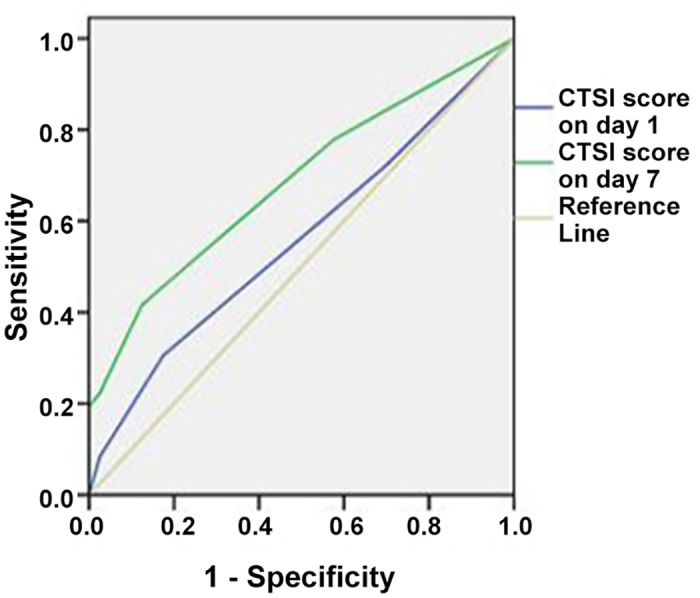
ROC curve of CTSI score on day 1 versus CTSI score on day 7 in predicting ACS.